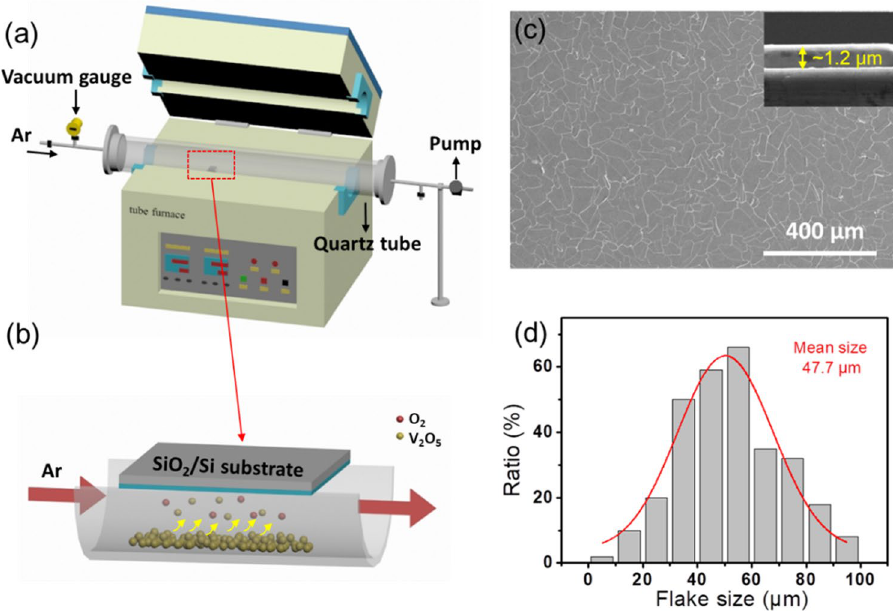
Figure 1. (a) Schematic diagram of the tube furnace reactor. (b) An enlarged diagram of the quartz boat loaded with V 2 O 5 powder and growth substrate. (c) Surface- and cross-sectional (the inset) SEM images of a complete VO 2 thin film. (d) A histogram of the size distribution of microplates in the VO 2 thin